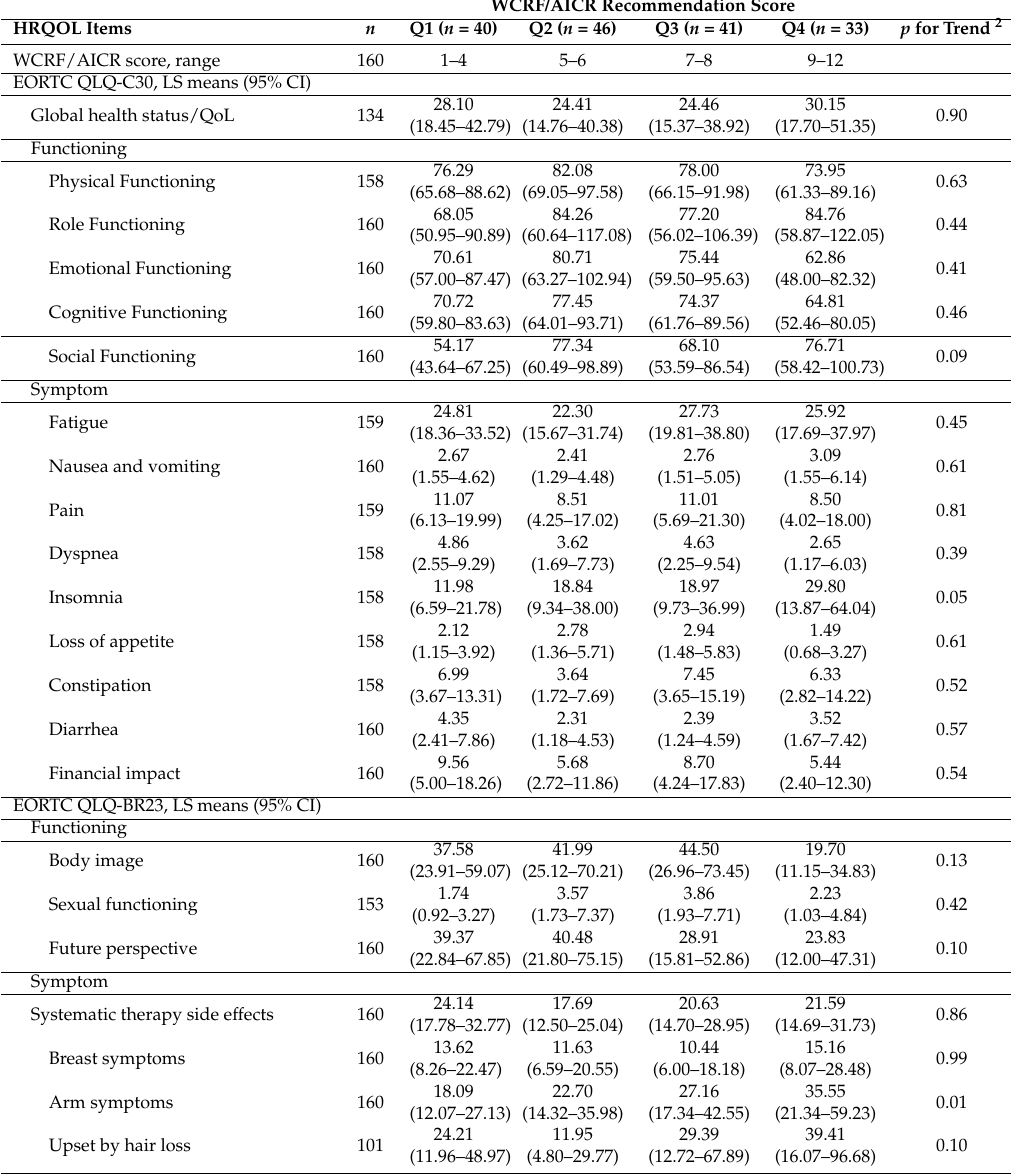
Table 5. Health-related quality of life (HRQoL) scores according to WCRF/AICR recommendation adherence score among breast cancer survivors with stage I to III ( n = 160) 1